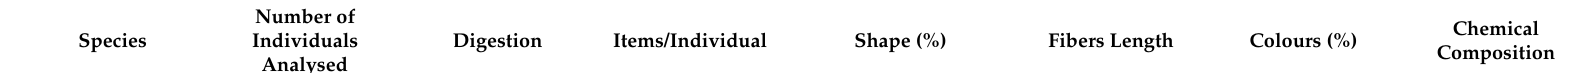
Table 3. Comparison of the results obtained in this study with previous ones in which the occurrence of MPs has been determined in commercial fish species at the regions of the Canary Islands or nearby